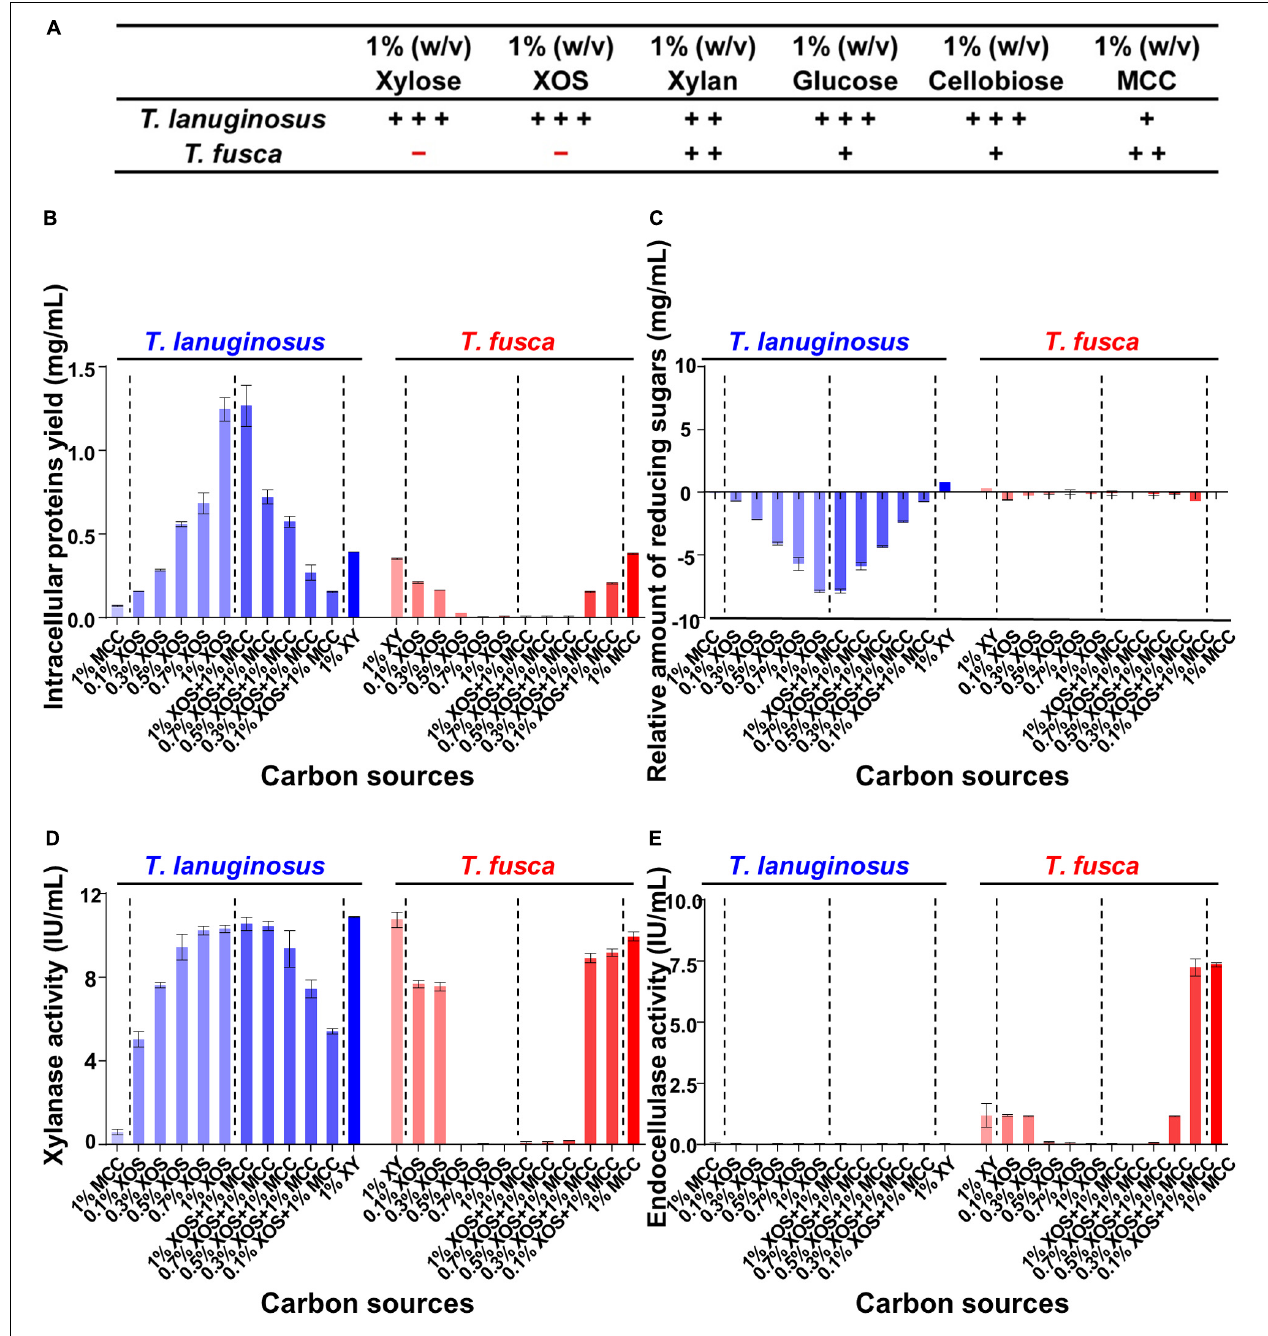
FIGURE 3 | Detection of the intracellular proteins and extracellular reducing sugars as well as enzyme activities when T. lanuginosus or T. fusca was grown alone on different carbon sources on day 5. (A) Growth characterization of T. lanuginosus or T. fusca grown on 1% (w/v) carbon sources. (B) Total intracellular protein yield representing the biomass of T. lanuginosus or T. fusca . (C) The relative amount of reducing sugars between day 5 and day 0. (D) Xylanase activity of the crude enzymes secreted by T. lanuginosus or T. fusca . (E) Endocellulase activity of the crude enzymes secreted by T. lanuginosus or T. fusca . T. lanuginosus represents the monoculture of T. lanuginosus . T. fusca represents the monoculture of T. fusca . + + +, significant growth; + +, growth; +, sparse growth; -, no growth. MCC, microcrystalline cellulose; XOS, xylo-oligosaccharide.